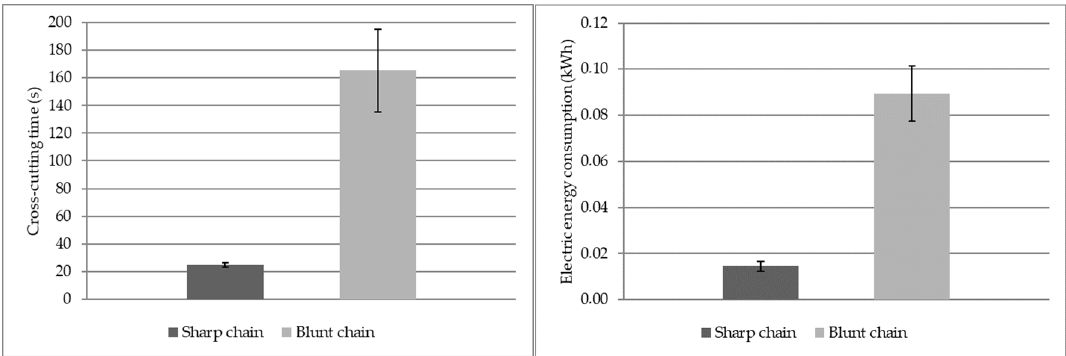
Figure 4. ( a ) Cross-cutting time consumption by chain sharpness—mean and 95 % confidence interval ( b ) Electric energy consumption by chain sharpness—mean and 95 % confidence interval.